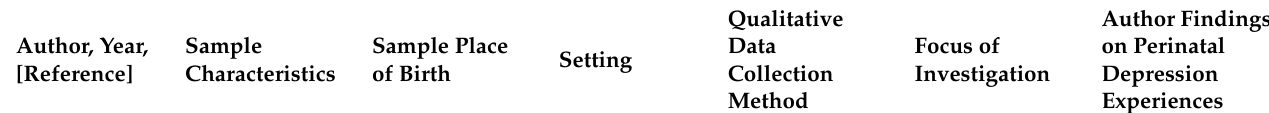
Table 2. Main characteristics of the included